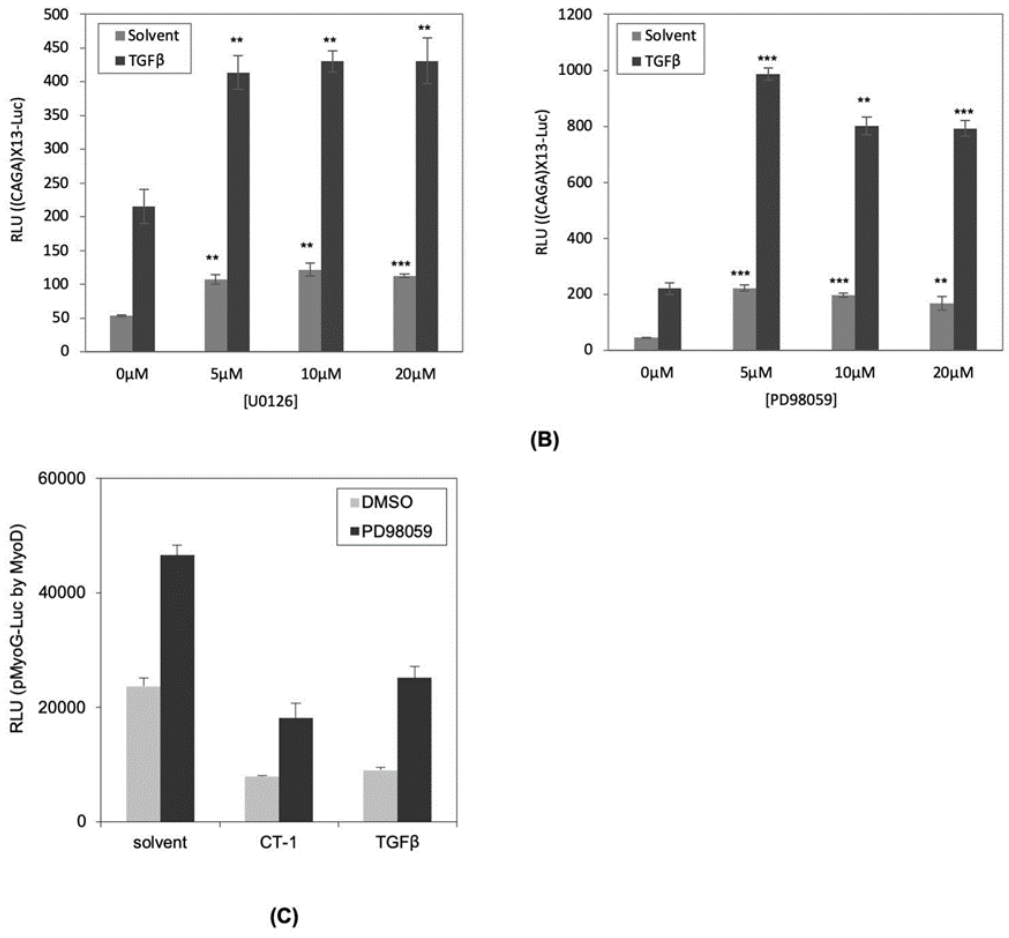
Figure 3. Pharmacological inhibition of MEK activation partially reverses the inhibitory effect of TGFβ on muscle differentiation. ( A ) C2C12 cells were seeded onto cell culture plates at equal density and maintained in TGFβ (1ng/mL) or solvent with or without indicated concentrations of U0126 for 72 (left panel) and 96 h (right panel). The cells were fixed and stained for muscle myosin heavy chain (MyHC) detection by immunochemistry (upper panel). The photomicrographs are representative fields in each condition (lower panel). ( B ) C2C12 cells were transfected with (CAGA)X13-luciferase reporter gene construct, and to monitor transfection efficiency, pCMV-β-gal construct was included in each condition. The transfected cells were maintained for 16 h in TGFβ (1ng/mL) or solvent with or without indicated concentrations of U0126 (left panel) or PD98059 (right panel). Total protein samples were harvested with a luciferase lysis buffer. Luciferase activity (RLU: relative luciferase unit) in each condition was measured independently and normalized according to β-galactosidase activity ( n = 3, +/- SD). The p-value was calculated relative to the control by two tailed T-Test (** p < 1X10-3, *** p < 1X10-5). ( C ) C2C12 cells were transfected with myogenin promoter-luciferase reporter gene construct (pMyoG-Luc) with MyoD expression vector, and to monitor transfection efficiency, pCMV-β-gal construct was included in each condition. The transfected cells were maintained for 16 h in TGFβ (1ng/mL), CT-1 (10ng/mL), or solvent with or without indicated concentrations of PD98059. Total protein samples were harvested with a luciferase lysis buffer. Luciferase activity in each condition was measured independently and normalized according to β-galactosidase activity. ( n = 3, +/- SD).